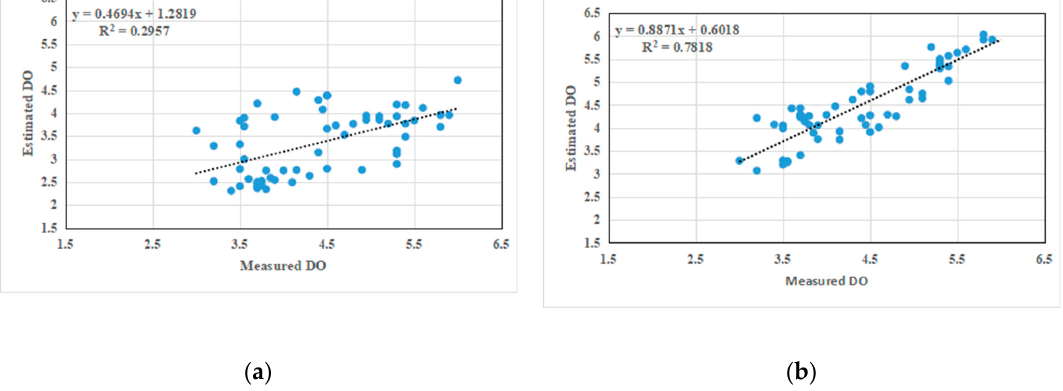
Table 3. The performance of the four models. 290